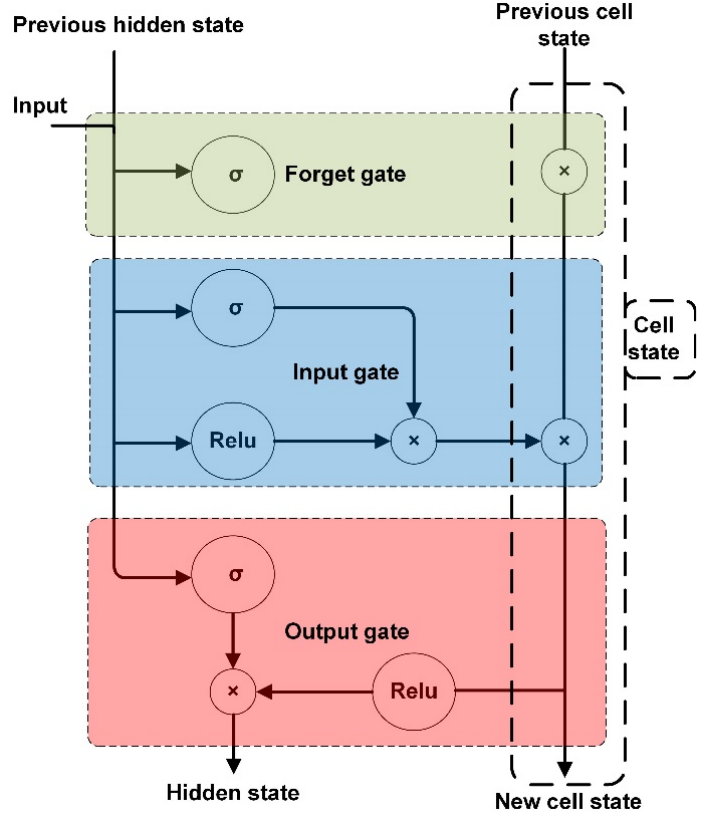
Figure 3. Architecture of the LSTM considered in this study.